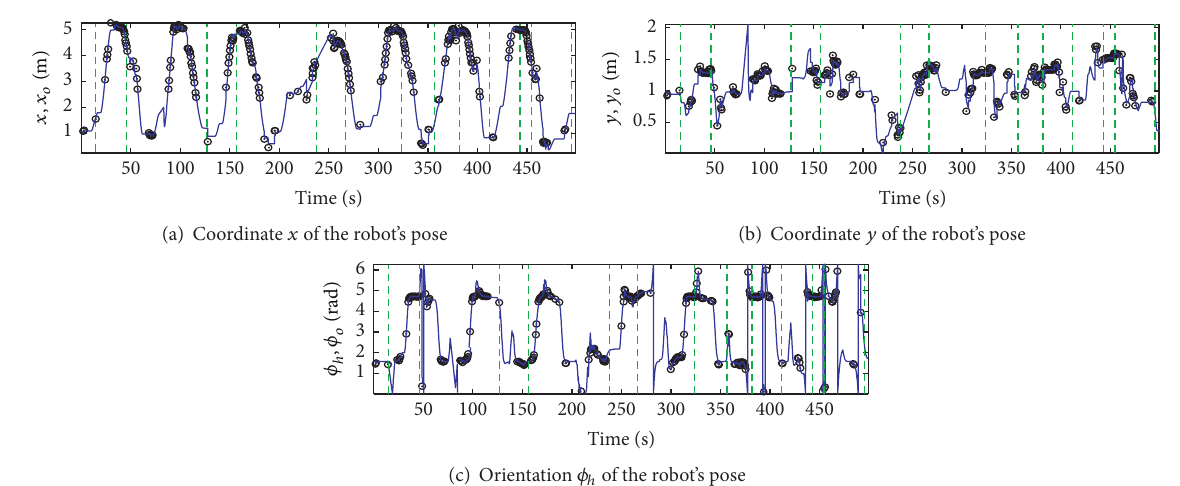
Figure 6: Estimation of the robot’s pose (𝑥,𝑦, 𝜙 ℎ ) (blue line), data of the robot’s pose acquired by the camera (black circles), and instants of time in which collisions occurred (green dashed lines).